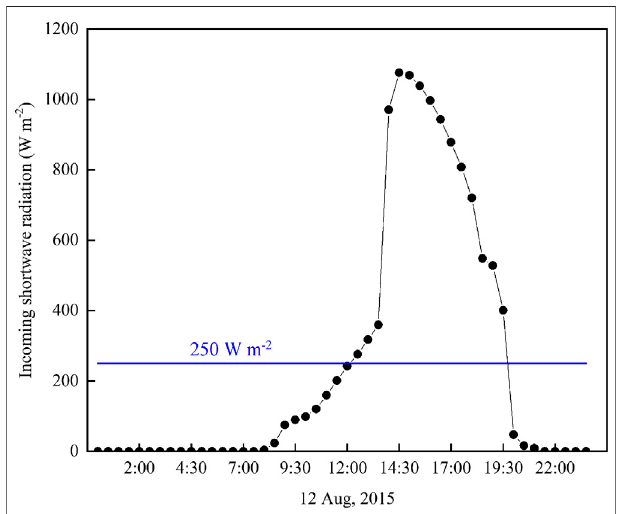
FIGURE 3 | The diurnal variations of incoming shortwave radiation at Urumqi Glacier No.1.